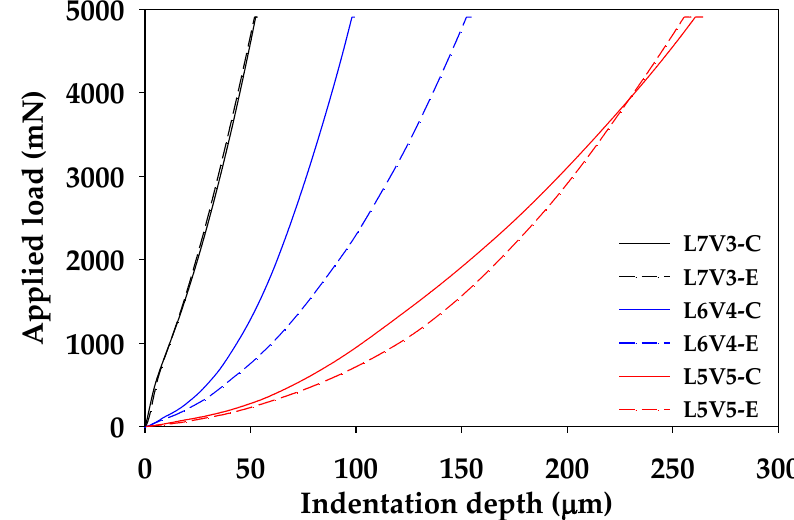
Figure 16. Micro-indenter testing curve of the blends at etching time of 7 days.